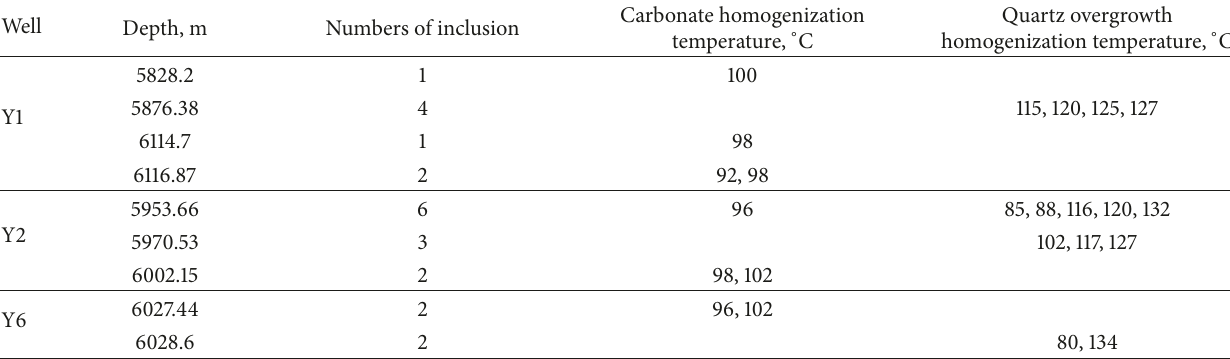
Table 3: Fluid-inclusion data from quartz overgrowth and carbonate cements.